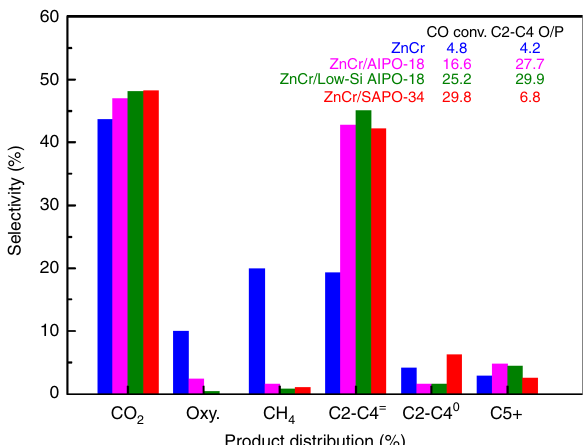
Fig. 2 Catalytic performance of bifunctional catalyst. Reaction conditions: 390 °C, 4.0 MPa, 1200 h − 1 , H 2 /CO = 1, OX/ZEO = 1 (Oxy.: oxygenates including ethanol and methyl ether; C2 – C4 O/P: C2 – C4 ole fi n/paraf fi n ratio; C2 – C4 = : C2 – C4 ole fi ns; C2 – C4 0 : C2 – C4 paraf fi ns; C5 + : hydrocarbon products with more than fi ve